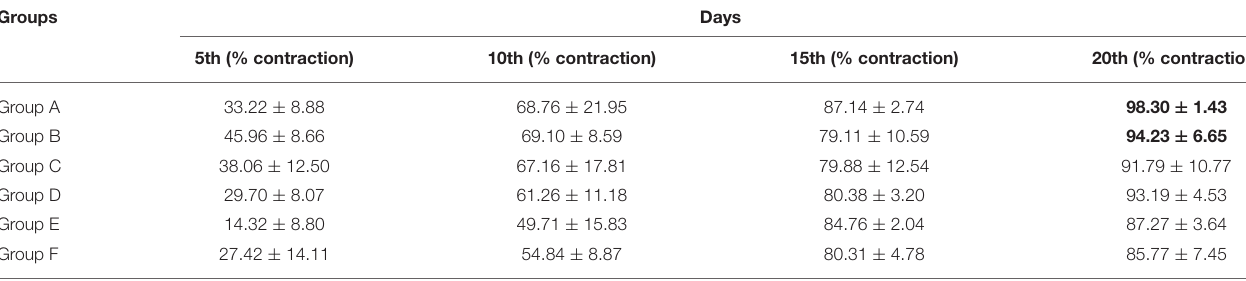
TABLE 2 | Effect of silver nanogel on excision wound model (percentage wound contraction) in albino Wistar rats. Groups